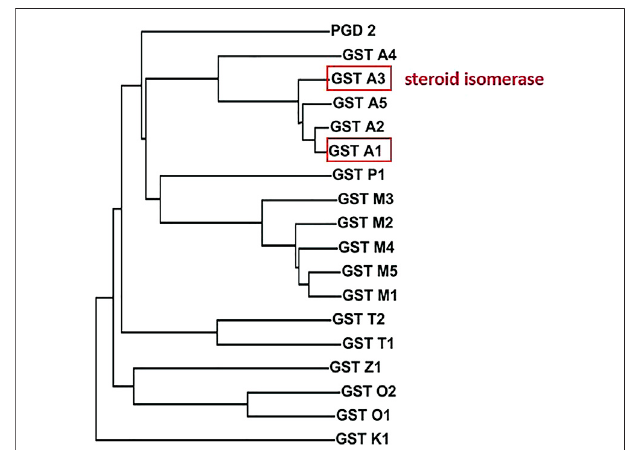
FIGURE1| Phylogramoftheaminoacidsequencesofthe18subunitsof soluble GSTs encoded in the human genome. The members of GST classes alpha, pi, mu, theta, zeta, omega, and kappa are distinguished by correspondinginitialletters, whereasthesigma classmember GSTS1is commonly referred to as prostaglandin D2 synthase (PGD 2). The catalytically active forms are dimers with broad but distinct speci fi cities for alternative substrates. Prominent ketosteroid isomerase activity with 5-and rosten-3,17- dione and 5-pregnen-3,20-dione is displayed by GST A3-3, and approximately 10-fold lower by GST A1-1, but not by other alpha class members or another